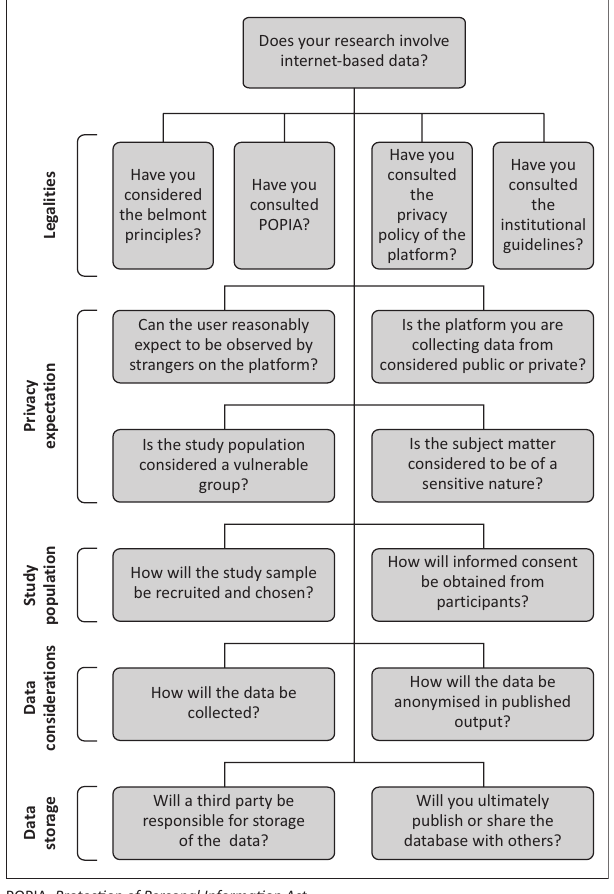
FIG URE 1: Internet-based research ethical guidelines